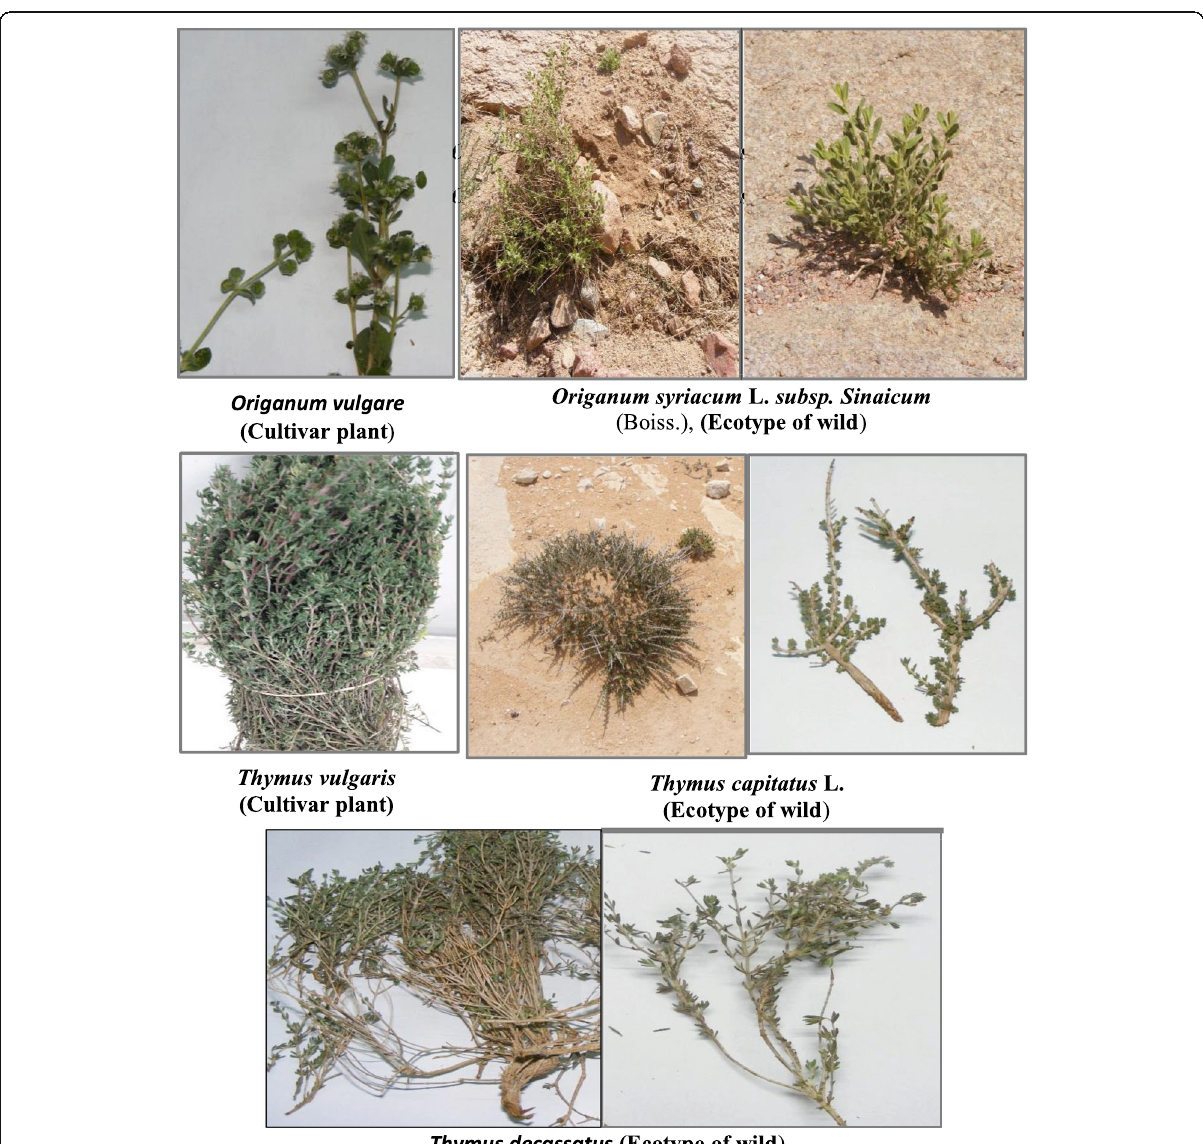
Fig. 5 Showing the Origanum species and Thymus species under